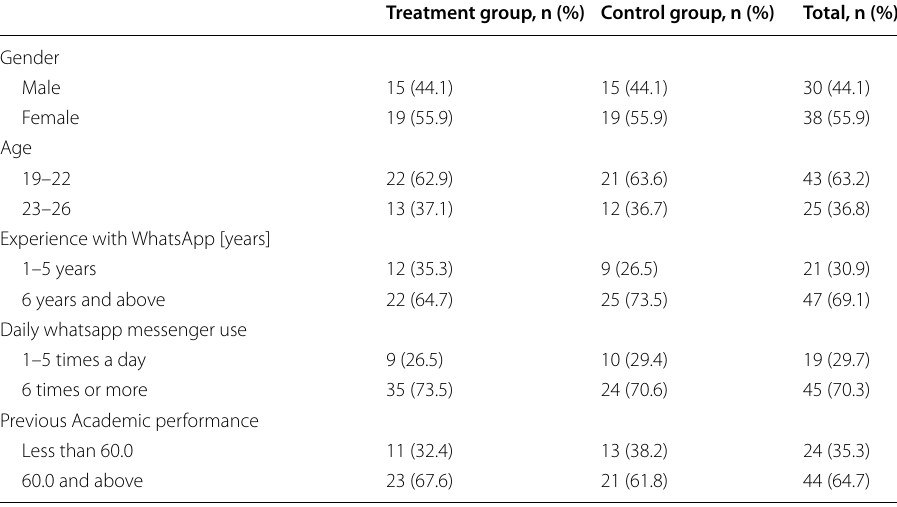
Table 1 Profile and traits of the 68 participants Treatment group, n (%) Control group, n (%) Total, n